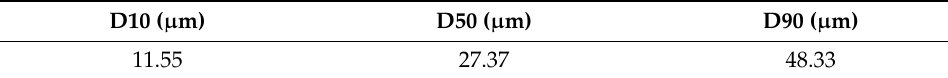
Figure 3. Particle size distribution of the −45 µm Ti-HDH (hydride-dehydride) powder. Table 2. Particle size distribution percentiles of the −45 µm Ti-HDH powder.